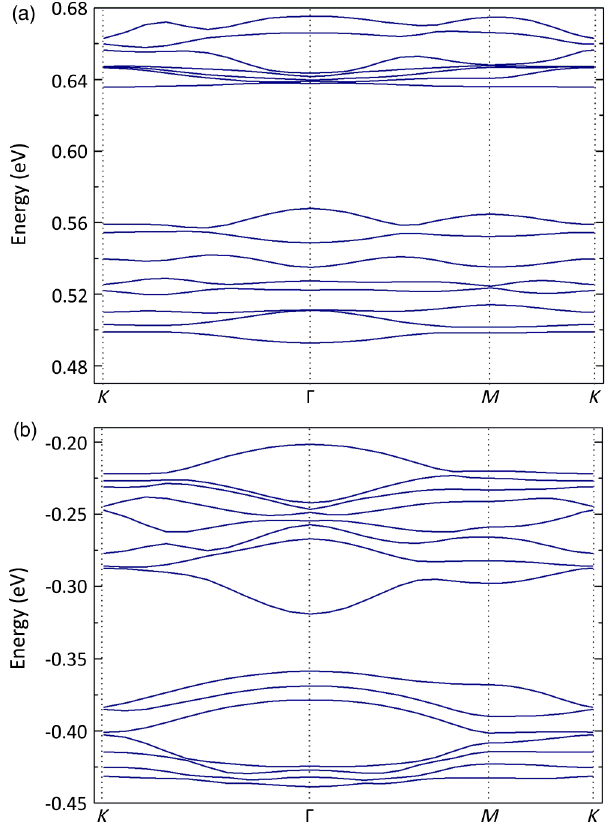
FIG. 9 (color online). (a) Lowest conduction bands and (b) high- estvalencebandsofagraphene-typehoneycomblatticeoftruncated nanocubes of PbSe (body diagonal of 5.00